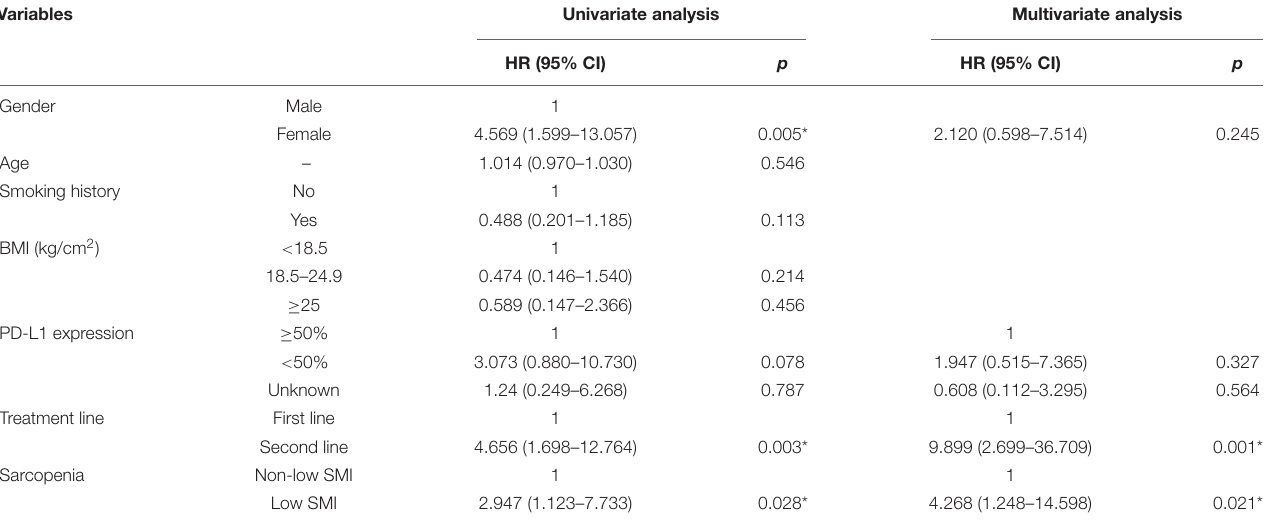
TABLE 2 | Univariate and multivariate cox-regression analysis of the risk of sarcopenia and clinicopathological factors on progression free survival (PFS) in patients receiving immune checkpoint inhibitors (ICIs). Variables Univariate analysis